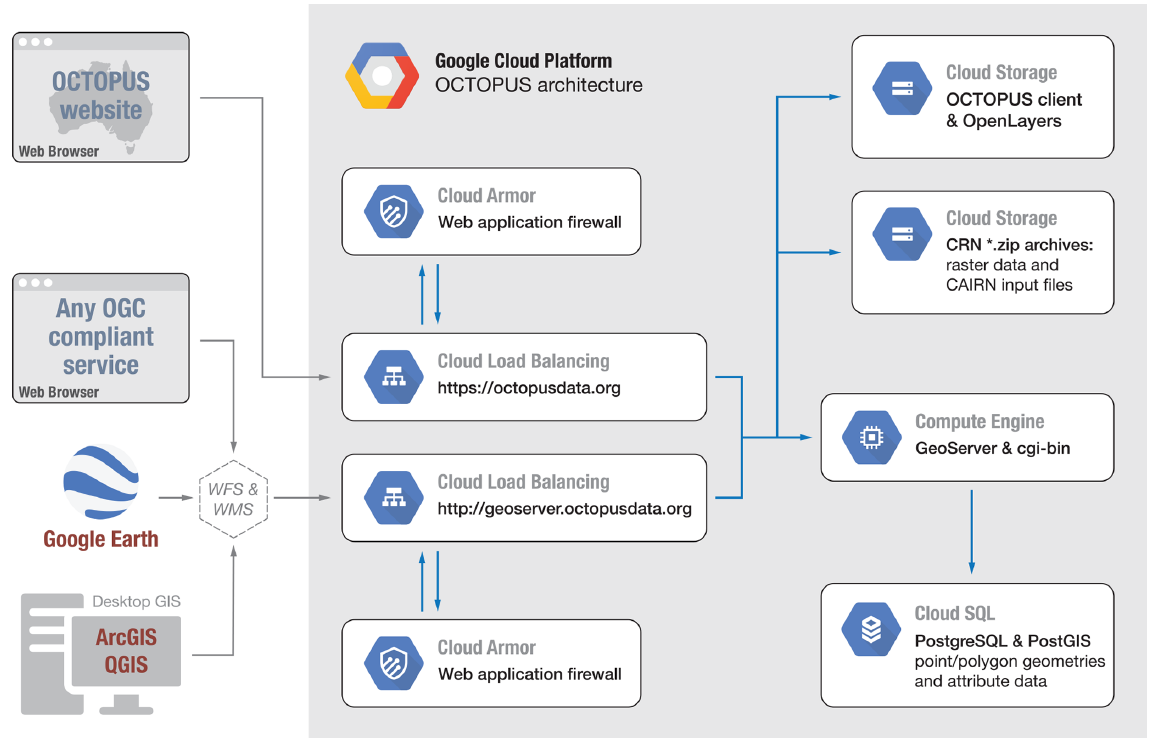
Figure 2. Schematic of the OCTOPUS v.2 Google Cloud Platform (GCP) set-up. See the text for more